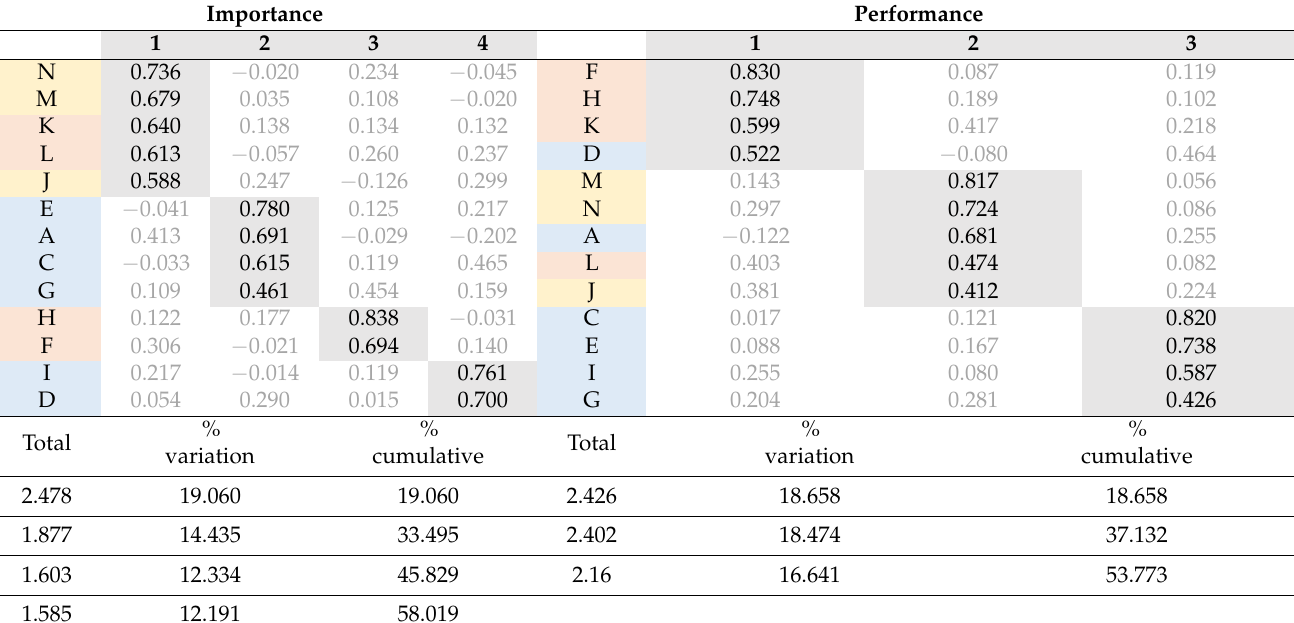
Table 9. Factor analysis (young